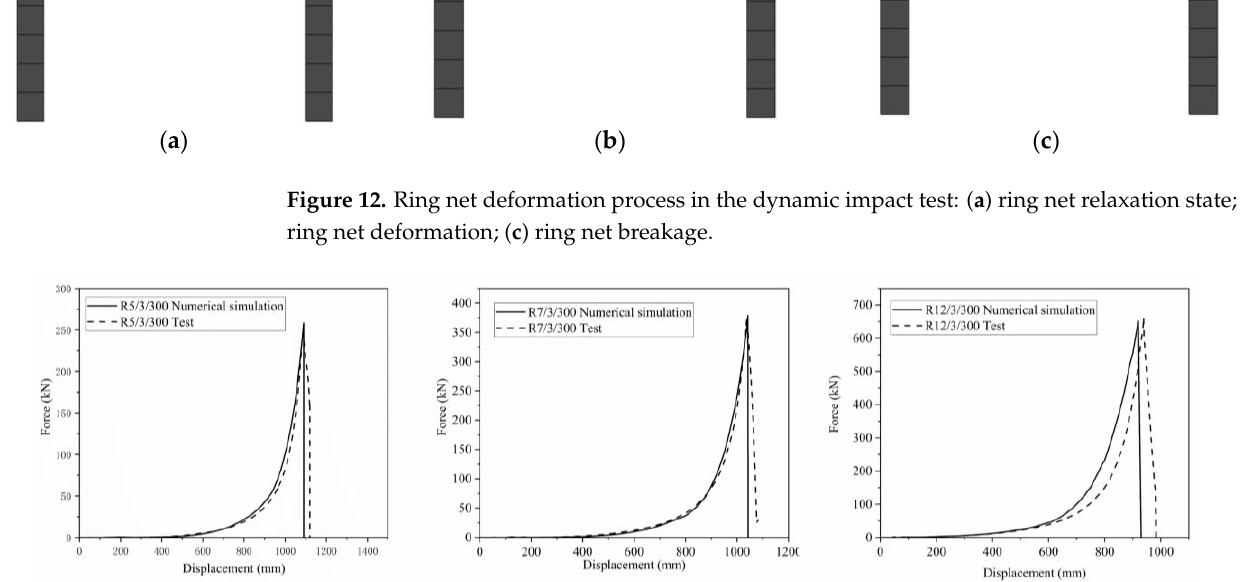
Figure 11. Ring net deformation process in the static punching test: ( a ) ring net relaxation state; ( b ) ring net deformation; ( c ) ring net breakage.